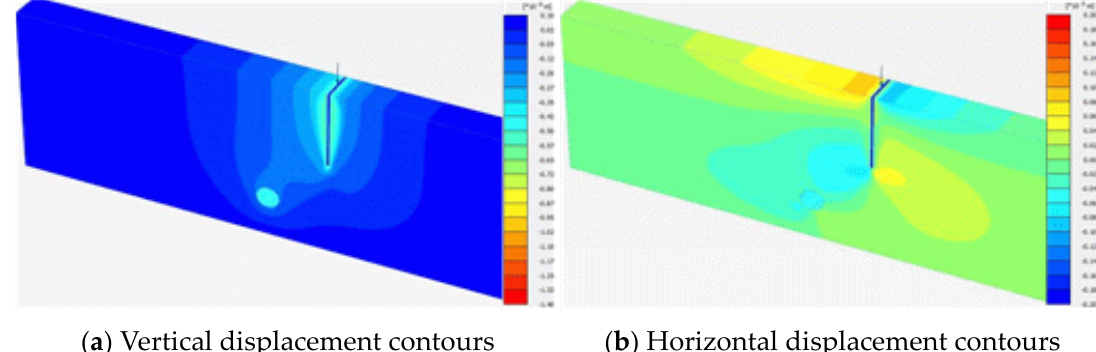
Figure 21. Displacement contours for allowable load (case 2-2).